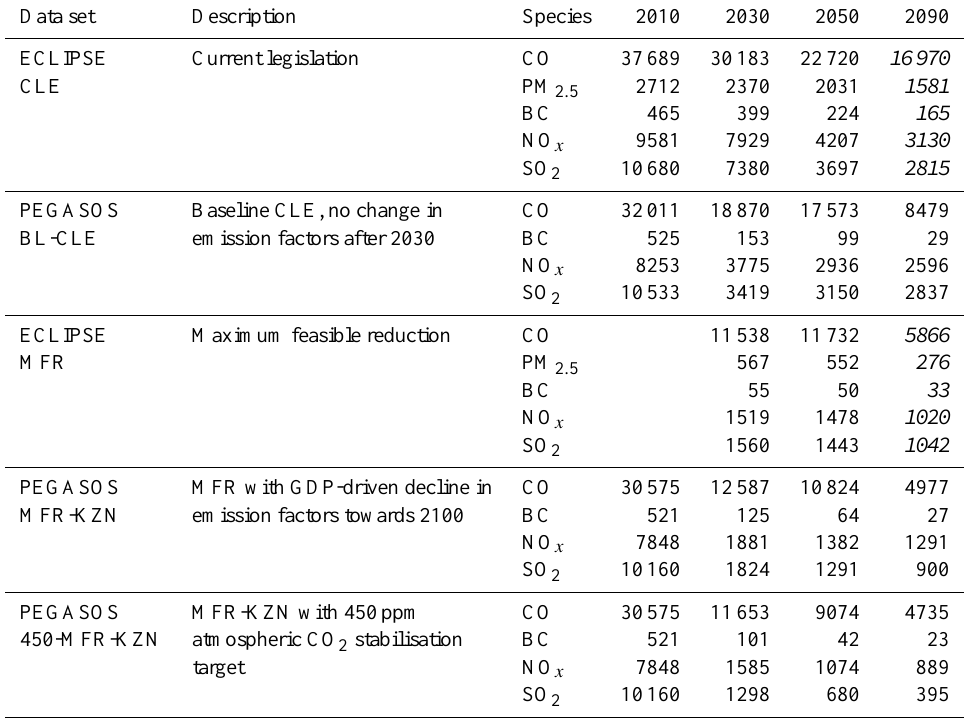
Table 2. Total anthropogenic emissions for European study